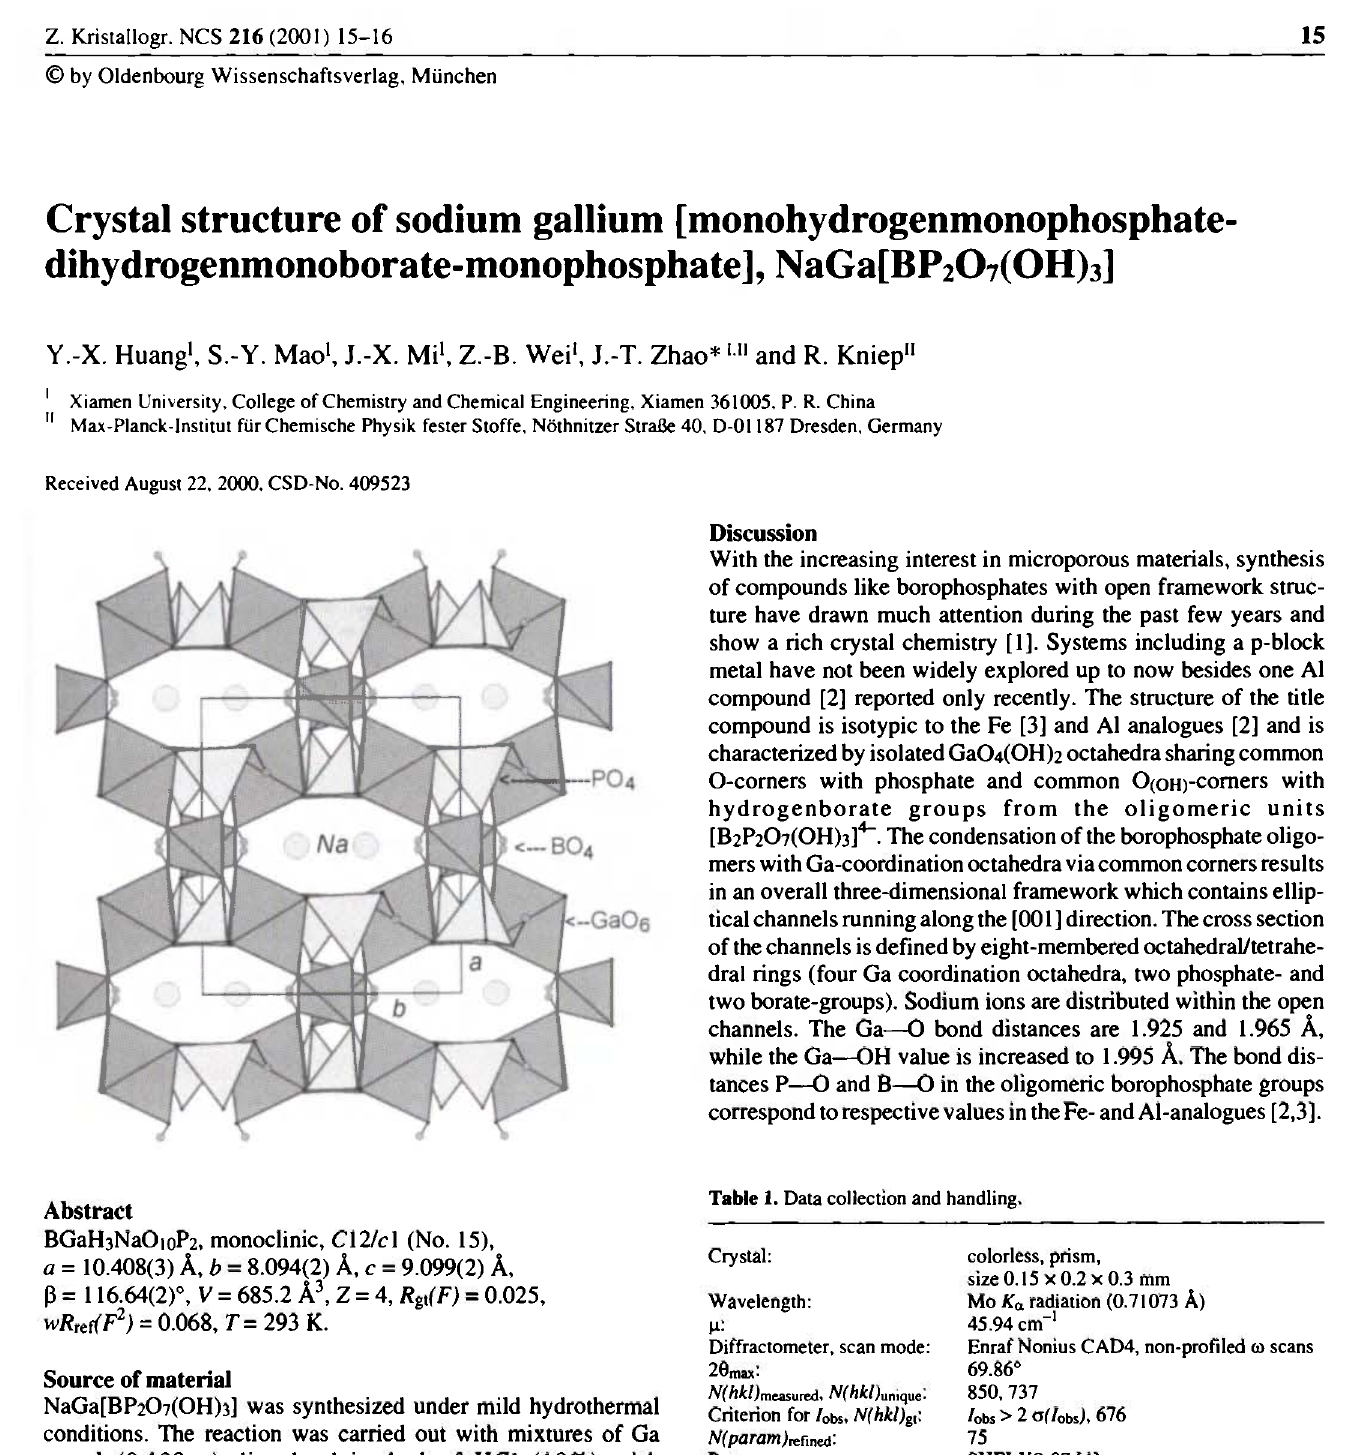
Table 2. Atomic coordinates and displacement parameters (in A 2